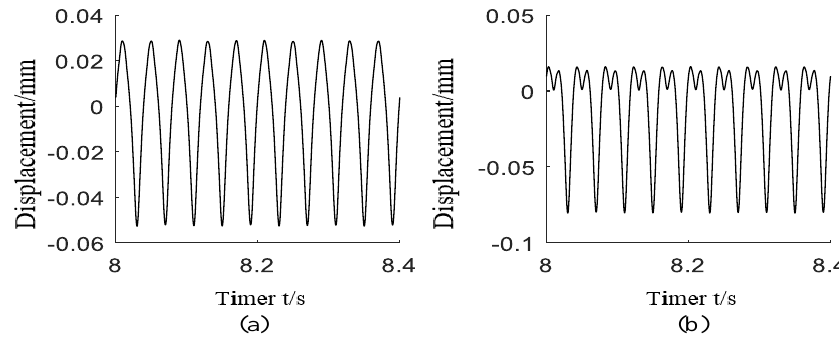
Figure 12. Vibration response axis locus of generator rotor: ( a ) misalignment 1.5 mm, short-circuit 5%; ( b ) misalignment 5 mm, short-circuit 5%.